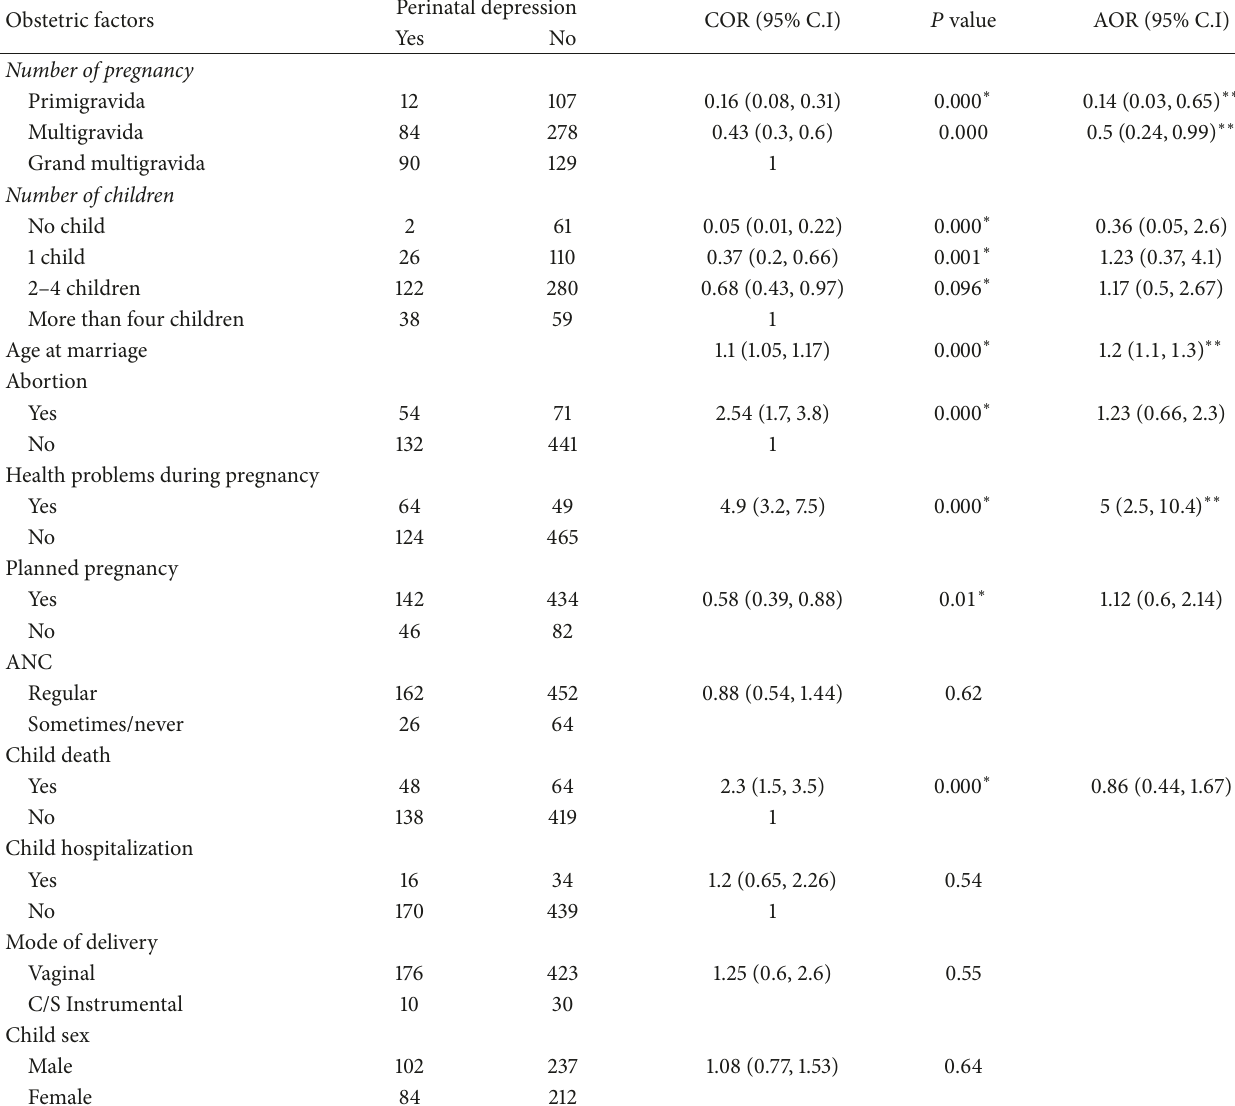
∗ Significant association in the bivariate analysis. ∗∗ Significant association in the multivariable